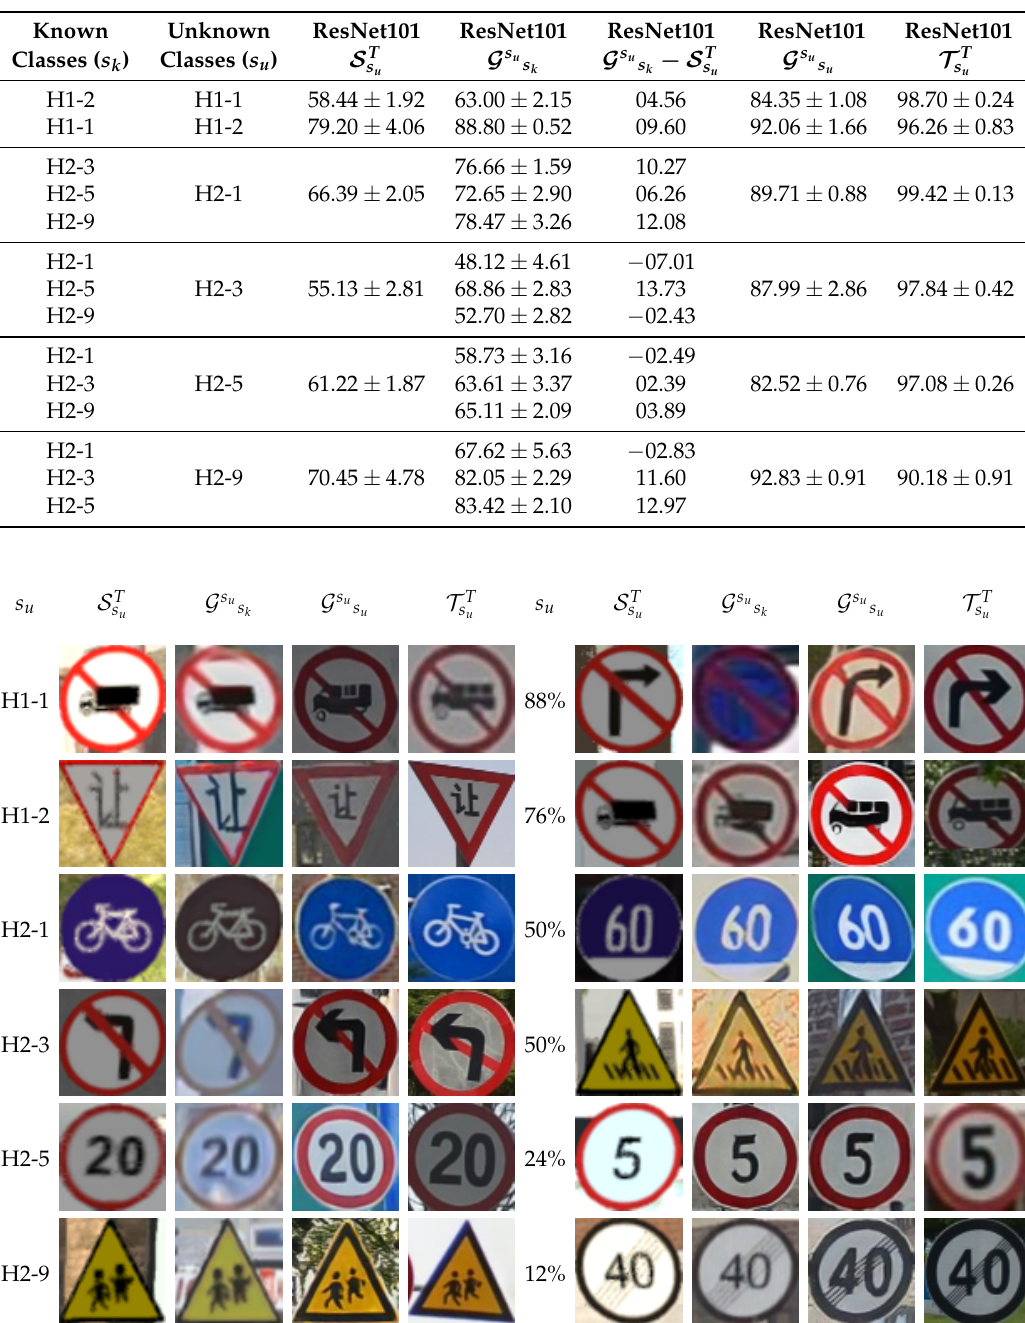
Table 5. Experiments to support Q1 analogously to Table 4, but using ResNet101.